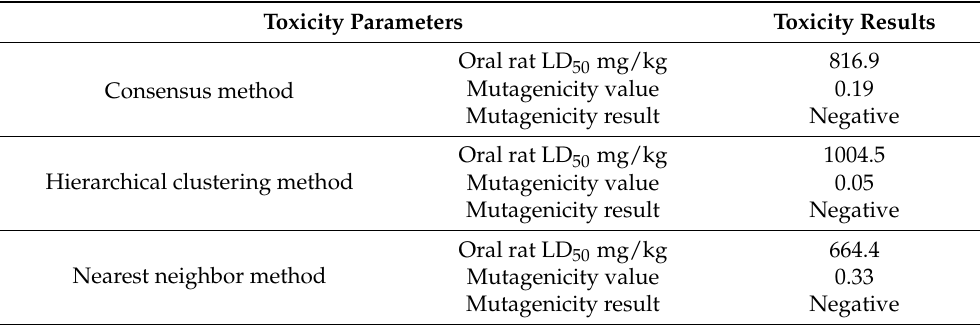
Table 3. The expected toxicities linked with the TQ as predicted by the T.E.S.T. software (US Environ- mental Protection